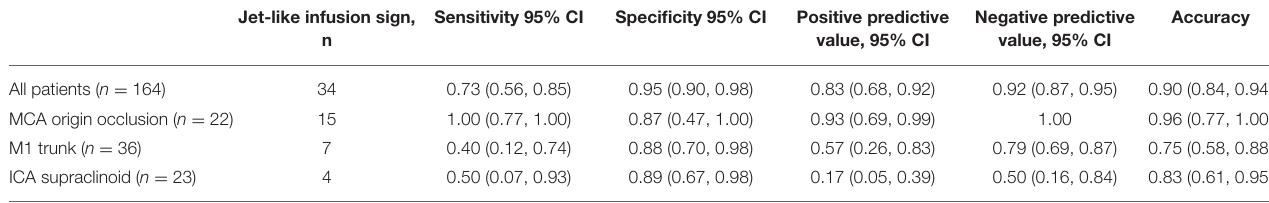
TABLE 4 | Diagnostic testing of Jet-like appearance for predicting ICAS-O. Jet-like infusion sign,